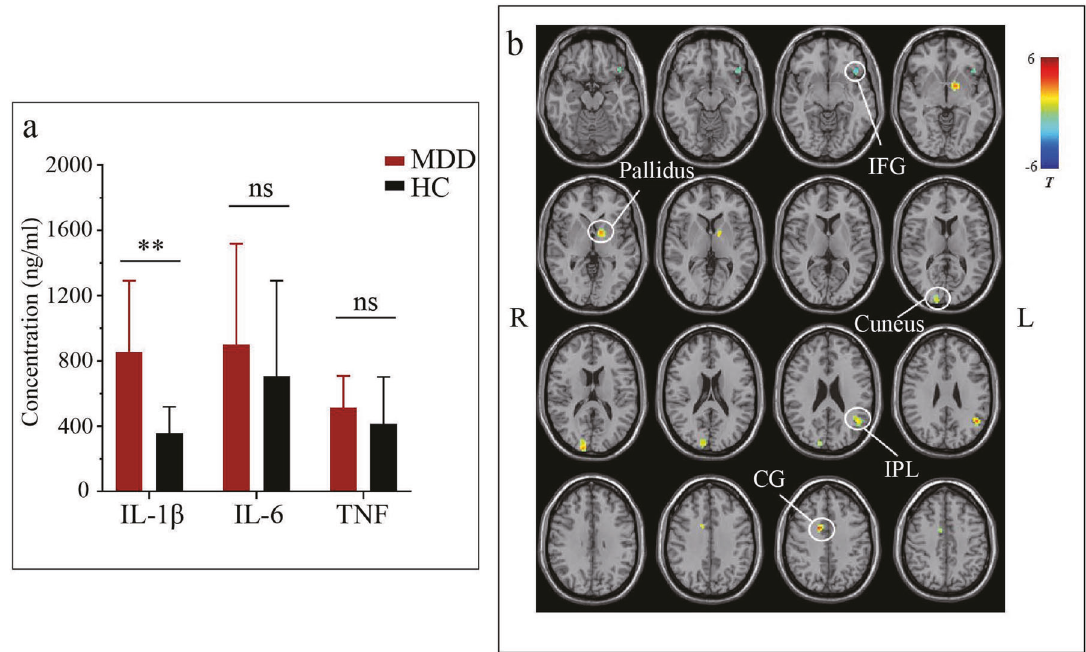
Fig. 4 Differences of plasma levels of in fl ammatory factor and Grey matter volume between MDD and HCs. a The data indicate that patients with MDD have signi fi cantly higher IL-1 β levels (858.30 ± 432.70 pg/ml) than HCs (359.52 ± 160.63 pg/ml). However, the MDD patients showed no signi fi cant change in IL-6 and TNF compared with HCs (901.03 ± 617.92 pg/ml vs. 707.31 ± 584.07 pg/ml, 514.12 ± 194.41 pg/ml vs. 414.87 ± 288.36 pg/ml, respectively). ns: p > 0.05, ** p < 0.001. b The cold color indicates decreased volume, and the warm color represents the increased volume in MDD compared with HCs. IFG Inferior frontal gyrus, IPL Inferior parietal lobe, CG Cingulate